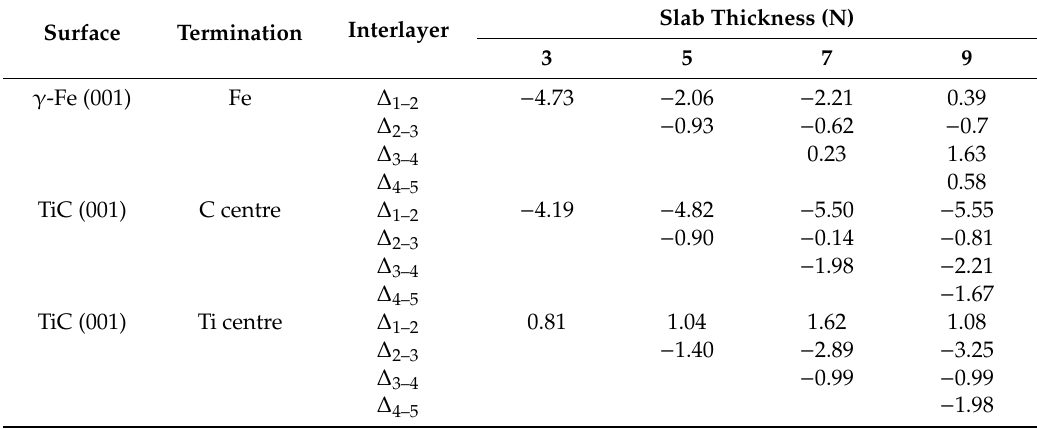
Table 2. γ -Fe (001) and TiC (001) surface relaxations as a function of termination and slab thickness.